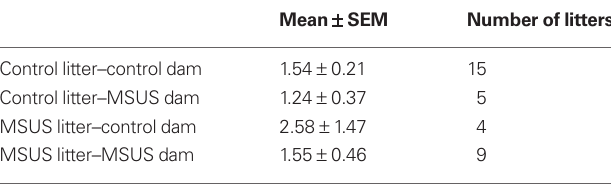
Table 5 | Sex ratio (male/female) within litters of F 2